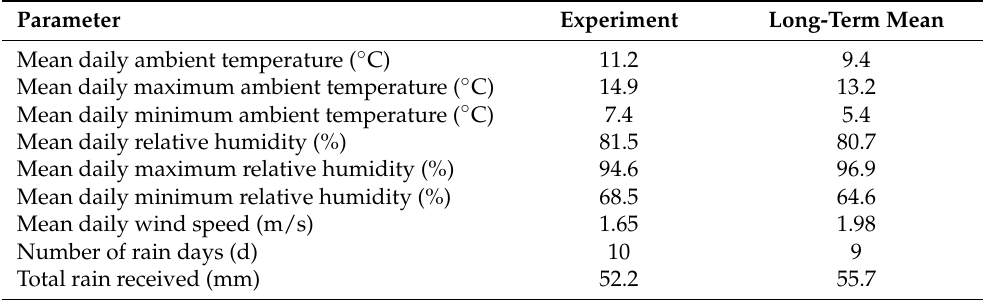
Table 1. Environmental conditions experienced during the 15 d experimental period along with long-term 40-year means for this period. Long-term data sourced from the SILO climate database: http://www.longpaddock.qld.gov.au/silo/ (accessed 17 June 2015). Parameter Experiment Long-Term